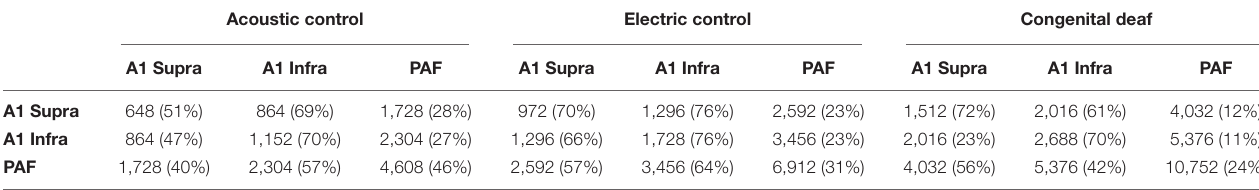
TABLE 1 | Total site-pairs with significant spike-field coherence coupling. Acoustic control Electric control Congenital